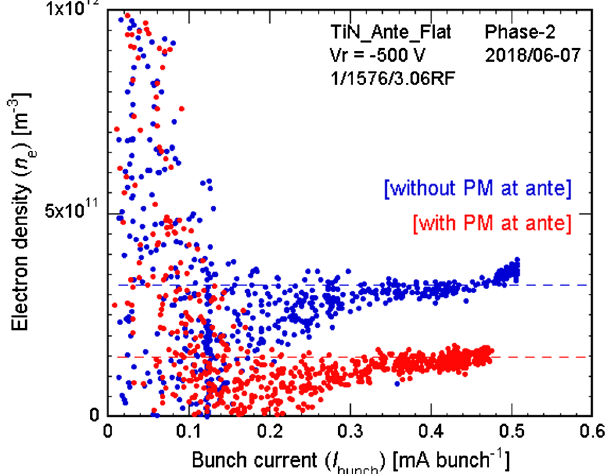
FIG. 17. Measured electron density ( n e ) near the beam orbit for the cases with and without PMs in the